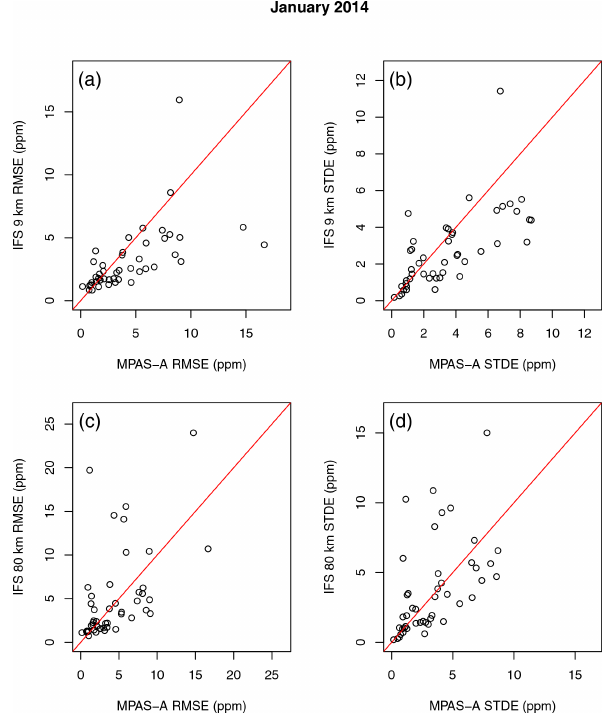
Figure 5. Comparison of model-simulated hourly CO 2 accuracy (RMSE and SE) between MPAS-A and IFS at 50 surface and tower stations. Each open circle in the figures represents a station. Com- parisons of MPAS-A with the IFS 9km resolution simulations are in panels (a) and (b) , and comparisons with IFS 80km resolutions simulations are in panels (c) and (d)